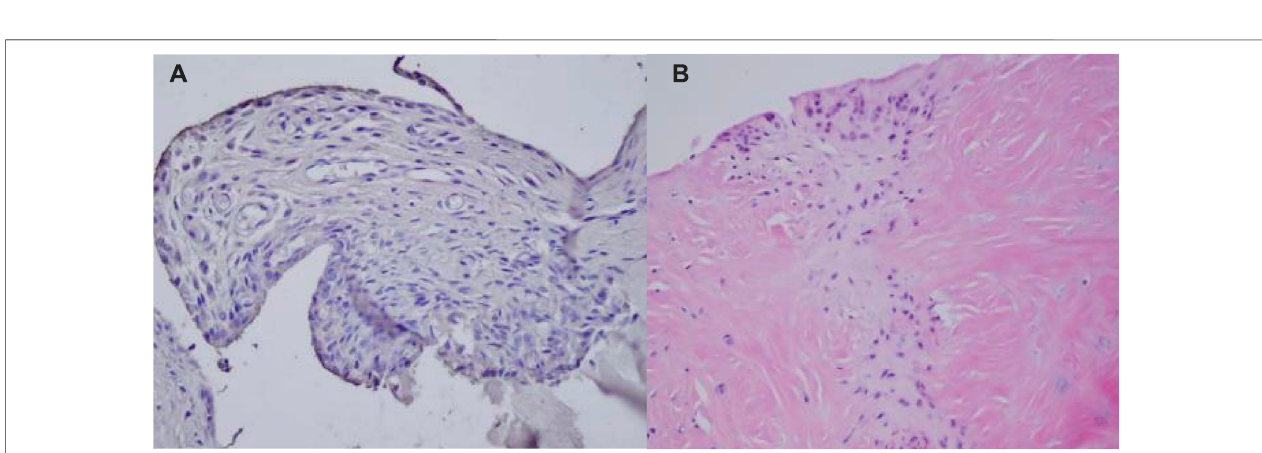
FIGURE 10 | Histological observation 4 weeks after surgery (The picture is from my experiment).